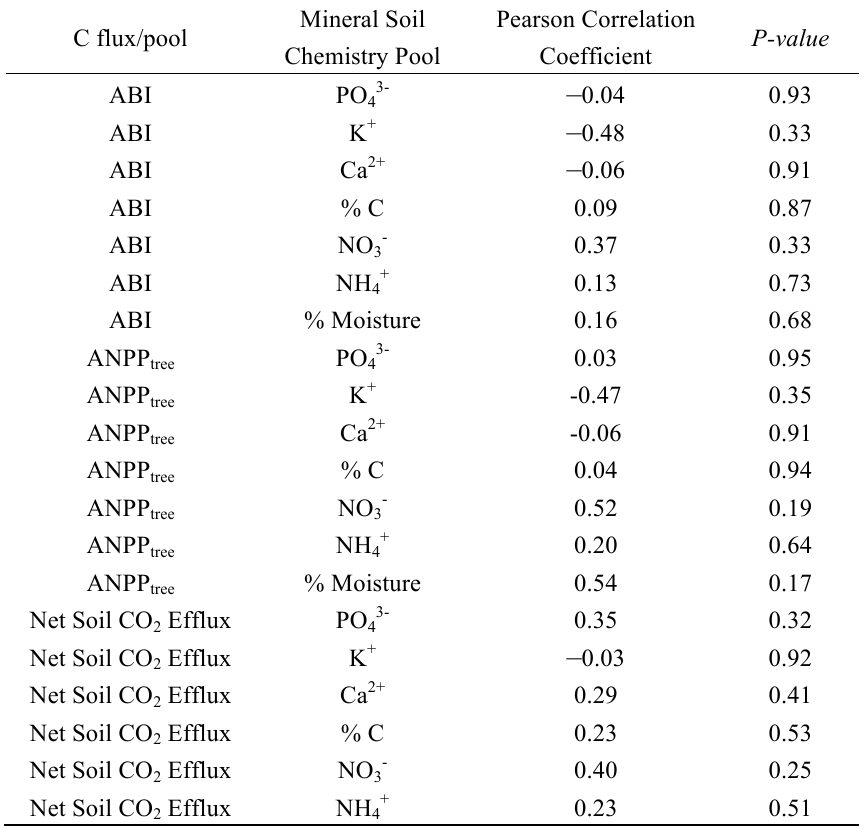
Table 6. Pearson Product Moment Correlation values and significance for C flux * versus mineral soil chemistry